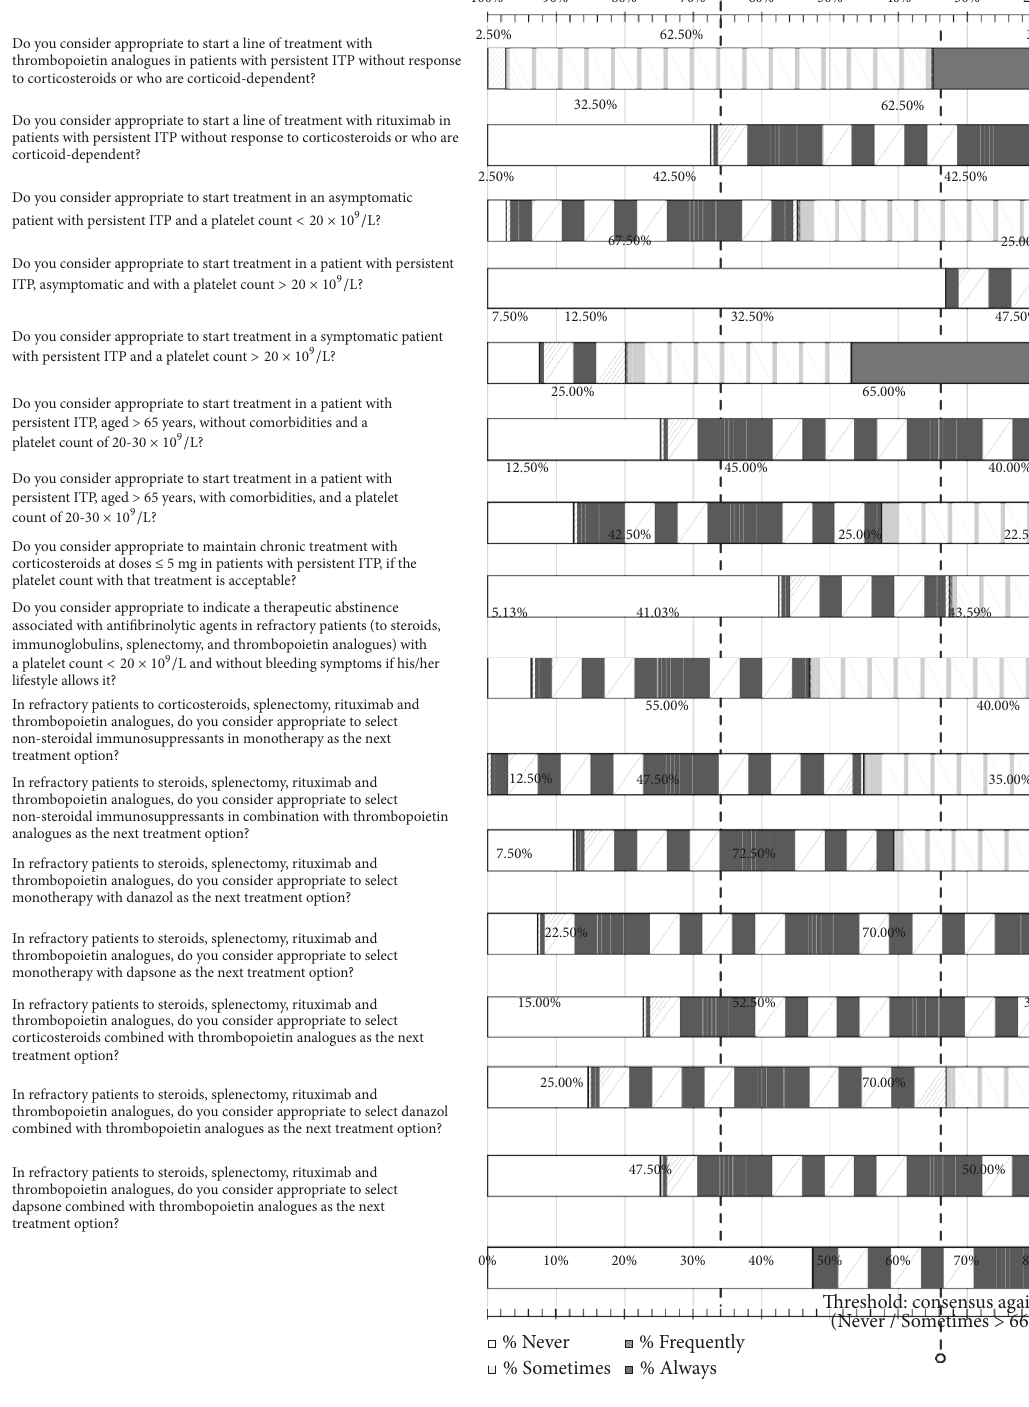
Figure 3: Results obtained in thesectionof thequestionnaireregarding persistentITP and refractorypatients. Distribution of thepercentages of